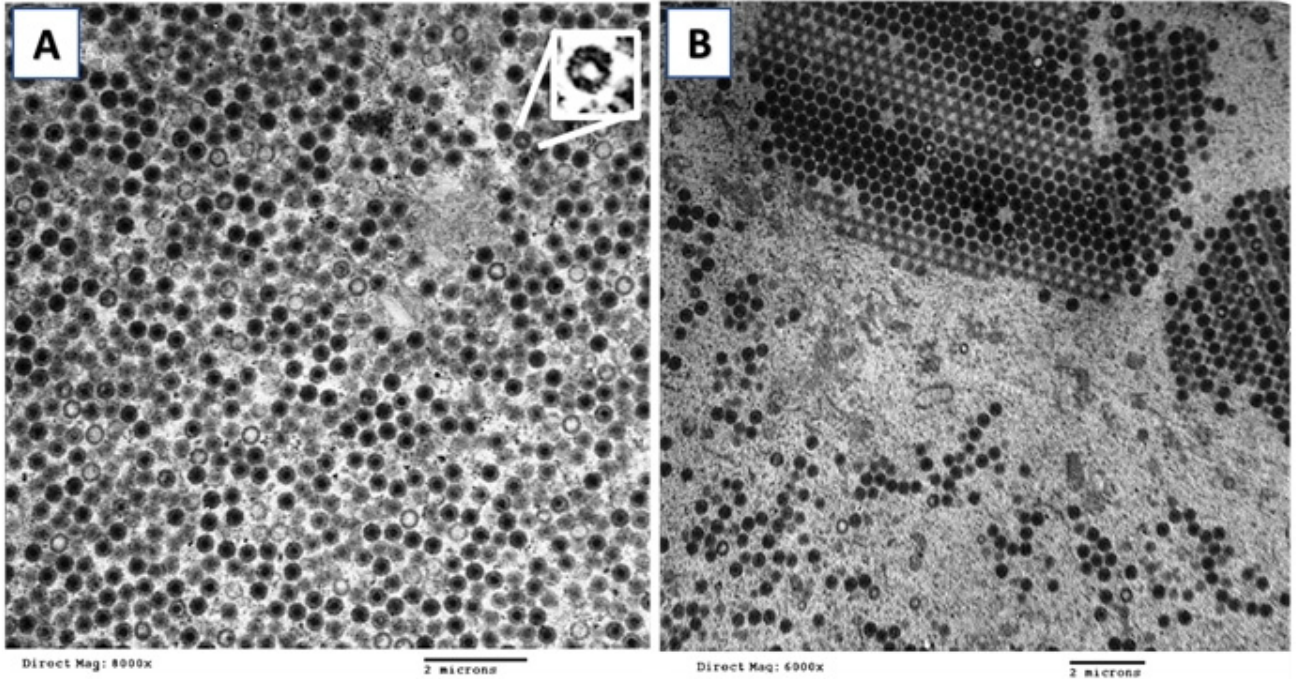
Figure 5. Transmission electron microscope images of ultra-thin sections of lymphocystis lesions on skin and fins of gilthead seabream ( Sparus aurata ). ( A ) Scattered large icosahedral particles in different stages of morphogenesis (8000×). Inset shows empty double-layered capsids. ( B ) Crystalloid structure with densely packed virus particles measuring about 350 nm with a dense core (6000×).